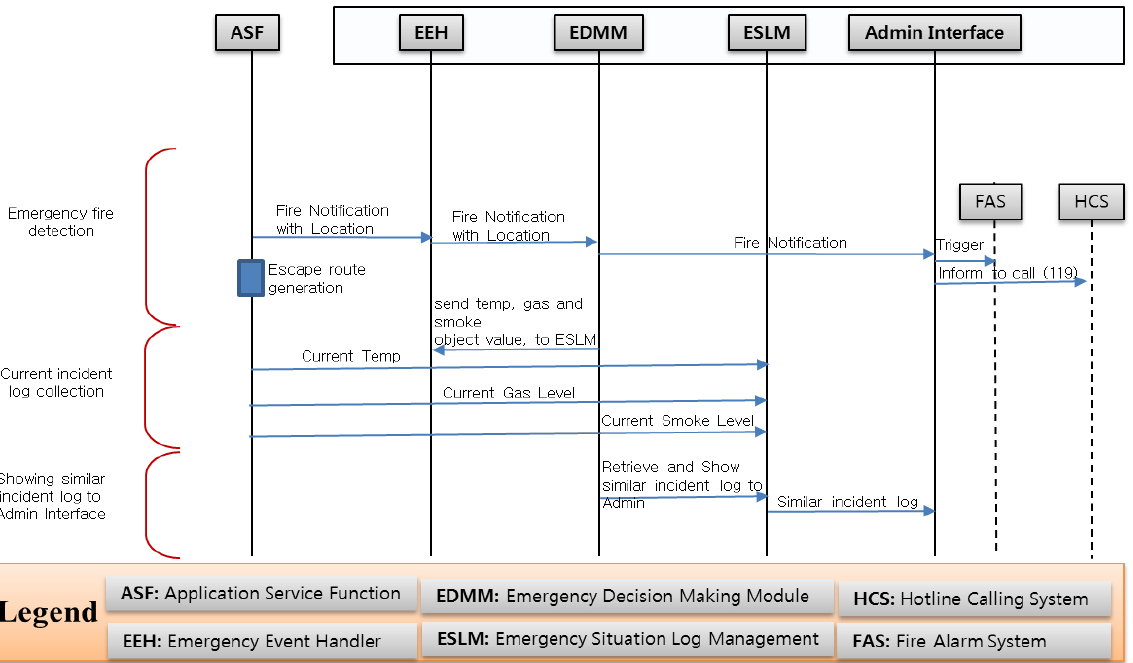
Figure 14. Sequence diagram for emergency fire management